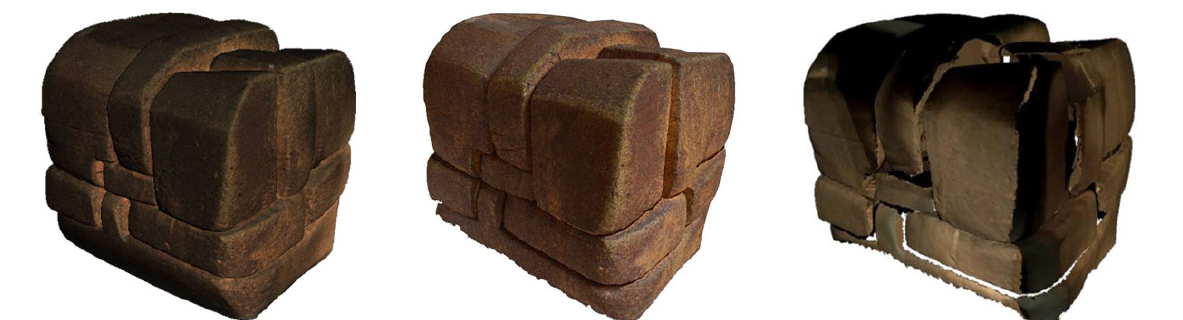
Figure 10. From left to right: model made with Artec Eva, Nikon D3200 and